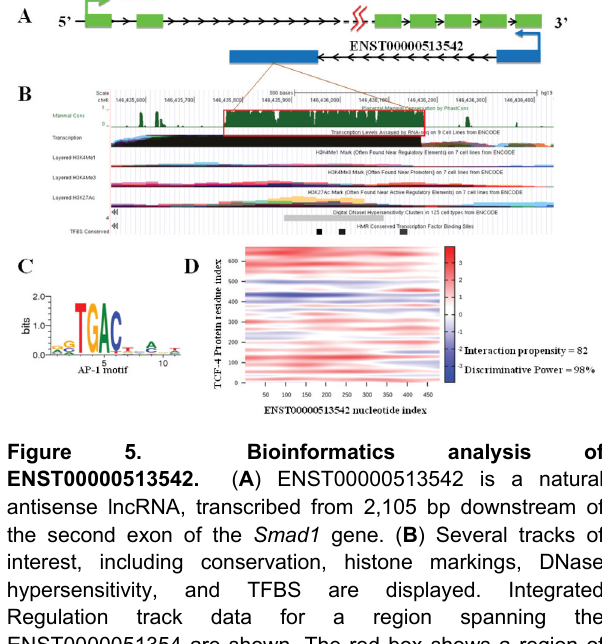
Figure 5. Bioinformatics analysis of ENST00000513542. ( A ) ENST00000513542 is a natural antisense lncRNA, transcribed from 2,105 bp downstream of the second exon of the Smad1 gene. ( B ) Several tracks of interest, including conservation, histone markings, DNase hypersensitivity, Integrated Regulation track spanning the overlap between the various tracks. ( C ) Transcription factor binding sites prediction indicated that ENST0000051354 loci combine with AP-1 as a cis-acting element. ( D ) Further catRAPID analysis indicated a